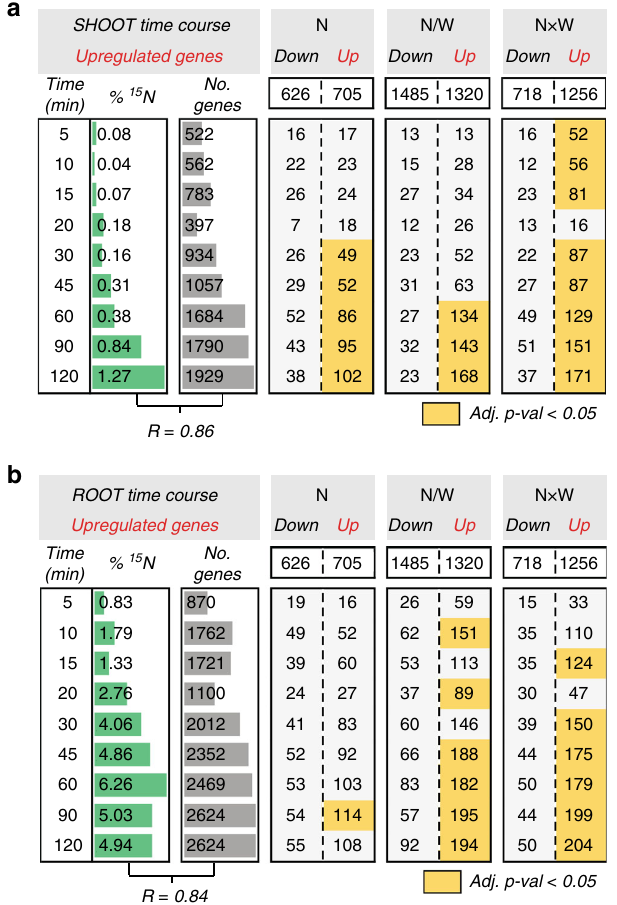
Fig. 3 All three N-responsive gene classes rapidly respond to a change in